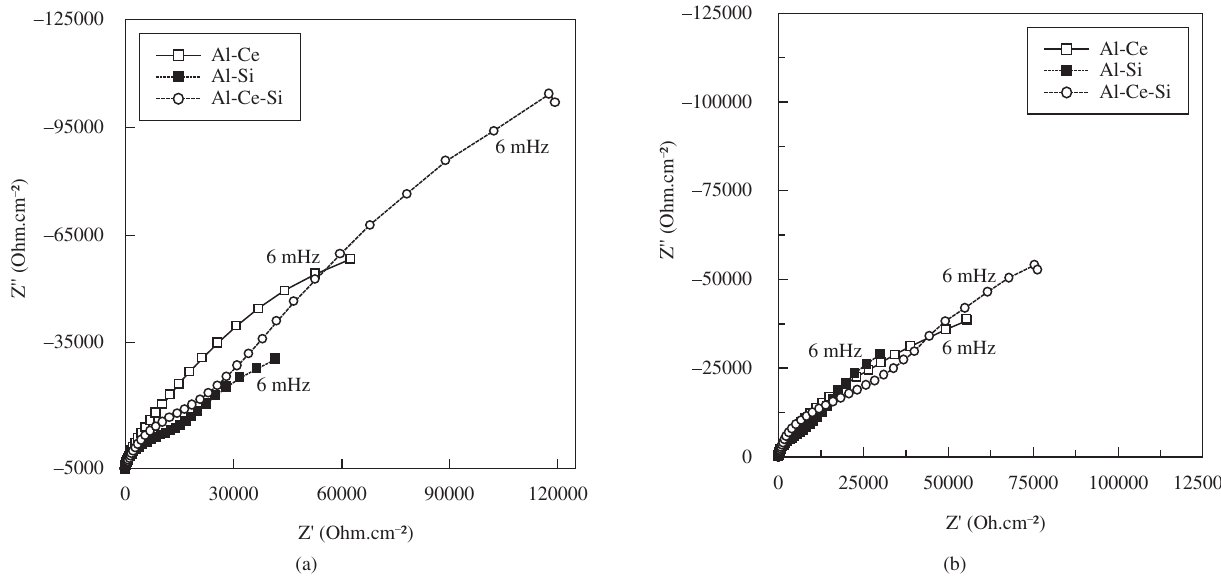
Figure 6. Impedance response in 0.1 M NaCl solution for AA 2024-T3 alloy with different treatments, a) before b) after ultrasonic bath. Immersion time 72